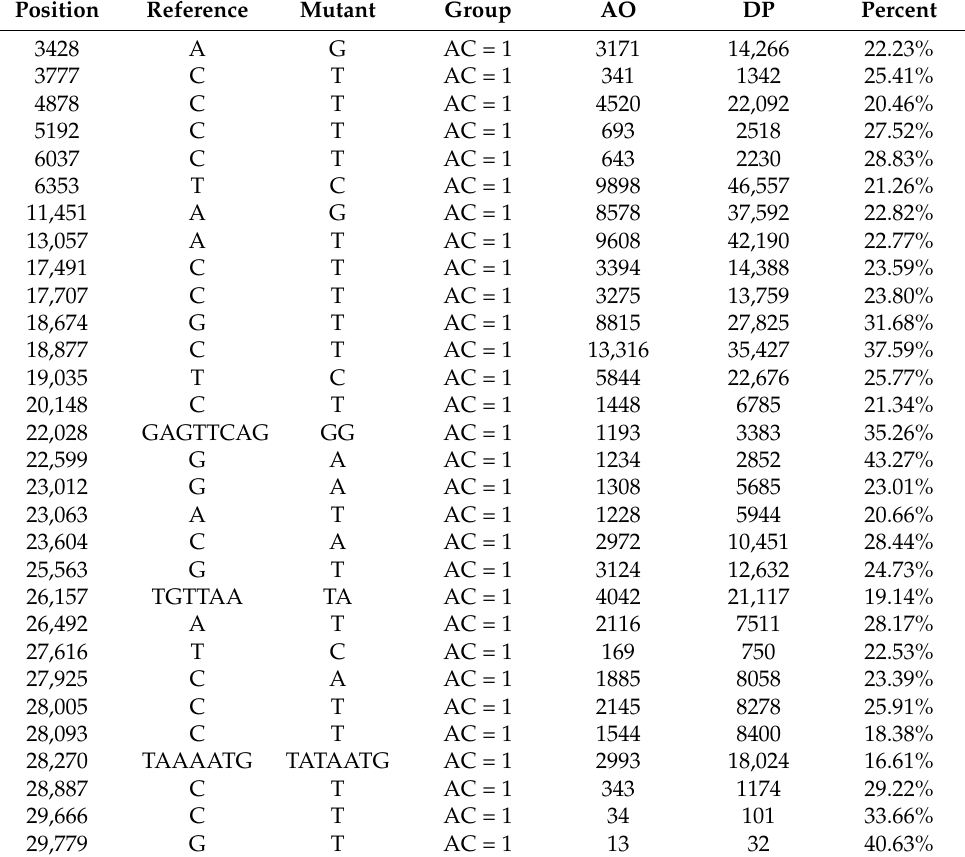
Table 6. Mutations present with fewer reads in sample M84 and detected only by